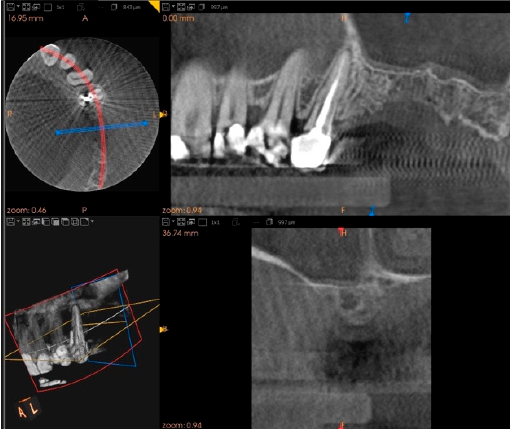
Figure 10. Cone-beam computed tomography (CBCT) shows bone volume preservation in the distal surface of the alveolus.